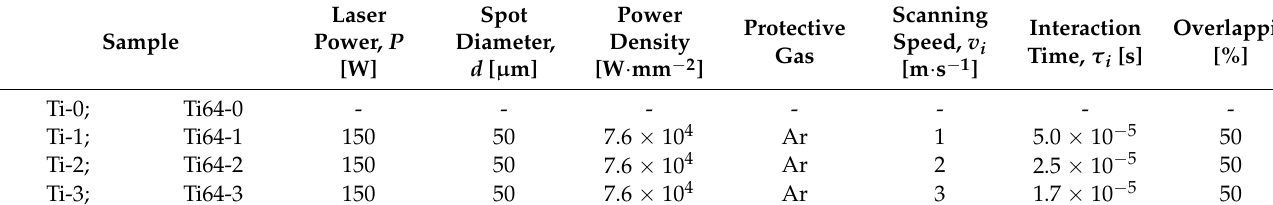
Table 2. Parameters of the laser post-processing treatment.